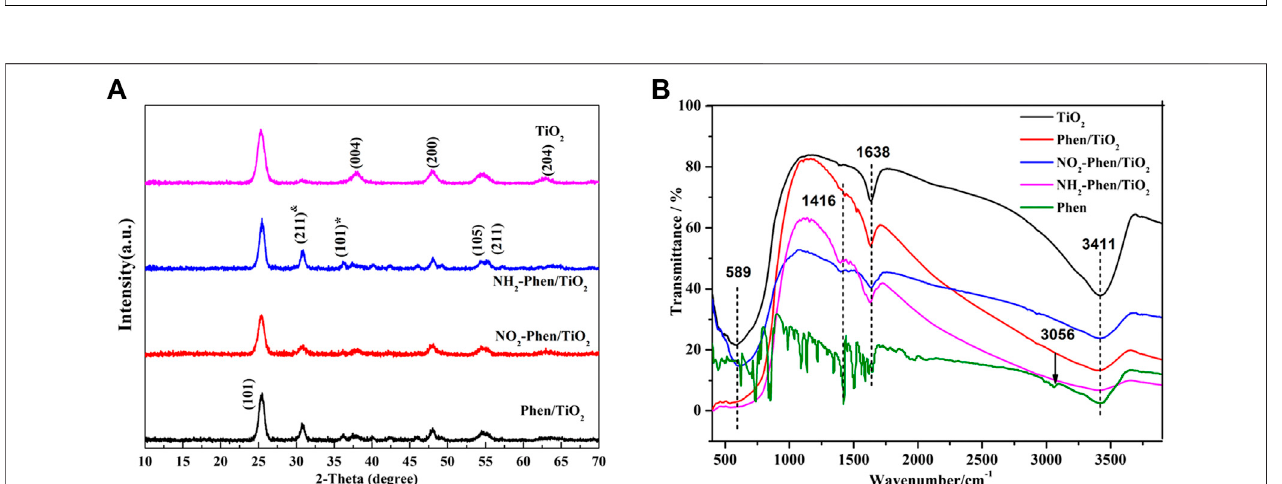
FIGURE 4 | XRD (A) and FT-IR patterns (B) of TiO 2 , Phen/TiO 2 , NO 2 -Phen/TiO 2 , and NH 2 -Phen/TiO 2 .